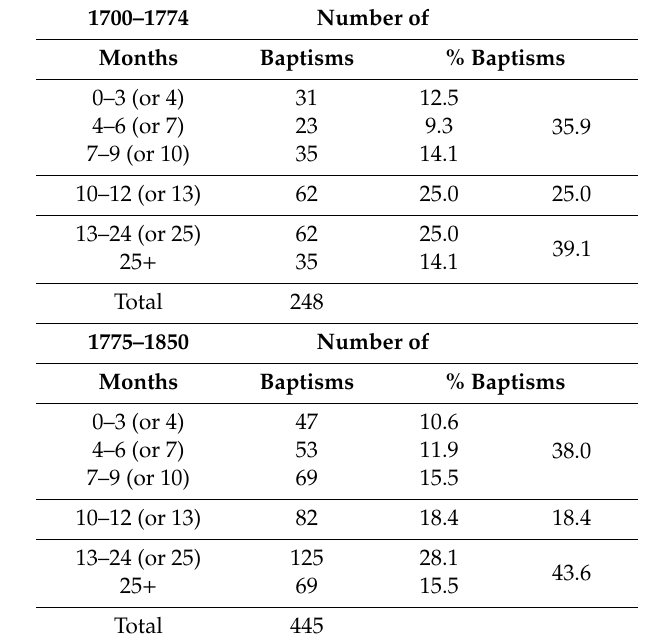
Table 2. Pre-Nuptial Pregnancy in Butleigh, Somerset, 1700–1850: number of months baptisms occurred after marriage